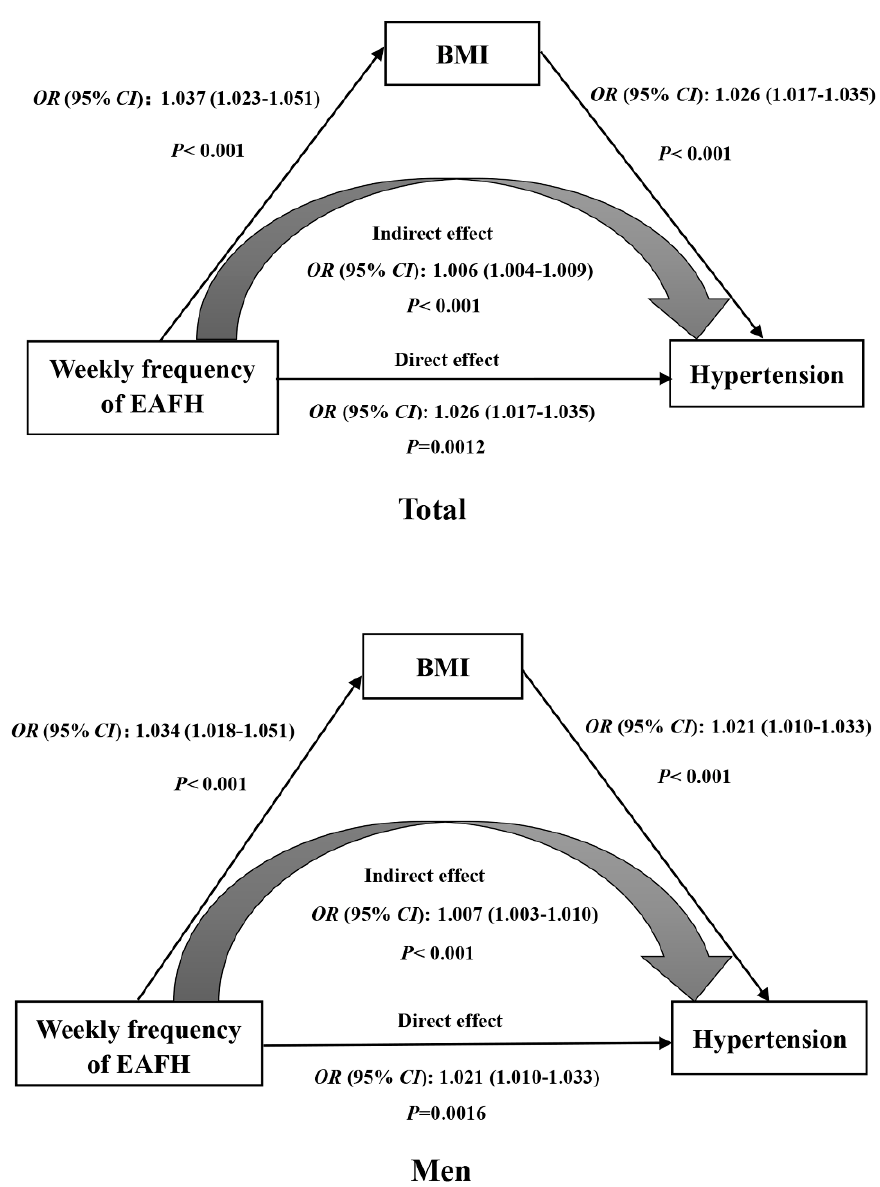
Figure 4. Mediation analysis of the relationship between the frequency of EAFH and hyper-tension by BMI for the total population and men. BMI body mass index; CI confidence interval; OR odds ratio. Adjusted for age, gender (only for total participants), marital status, education level, average income per month, smoking status, alcohol consumption, physical activity, abundant vegetable and fruit intake, high fat diet and family history of hypertension.